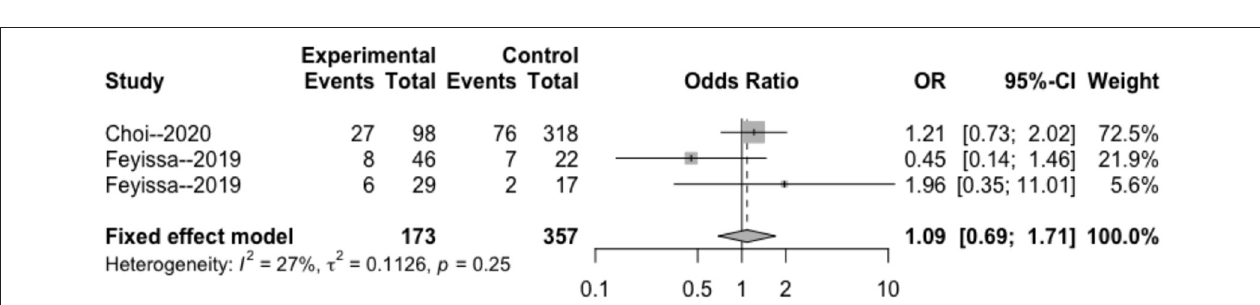
FIGURE 2 | Forest plot of the correlation between IDH mutation and perioperative epilepsy. CI, confidence interval; IDH, isocitrate dehydrogenase; OR, odds ratio.